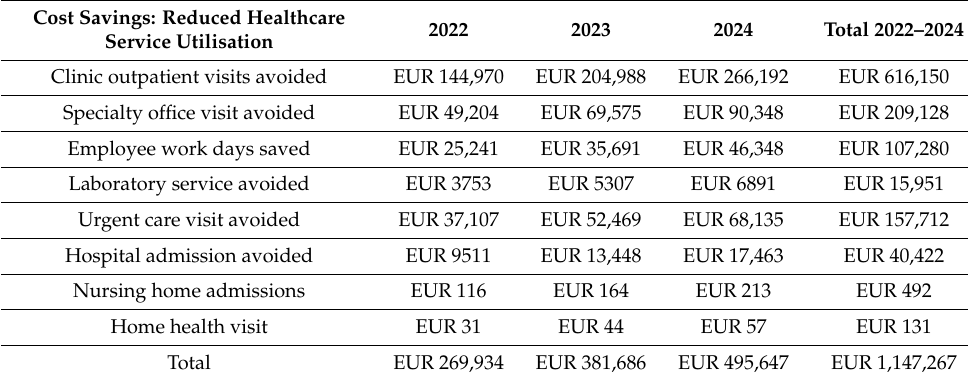
Table 10. Cost savings: reduced healthcare service utilisation.